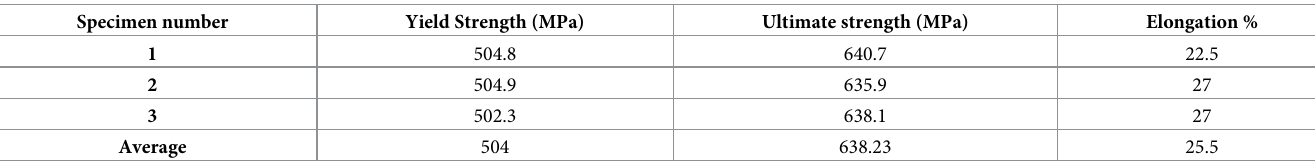
Table 3. Properties of steel